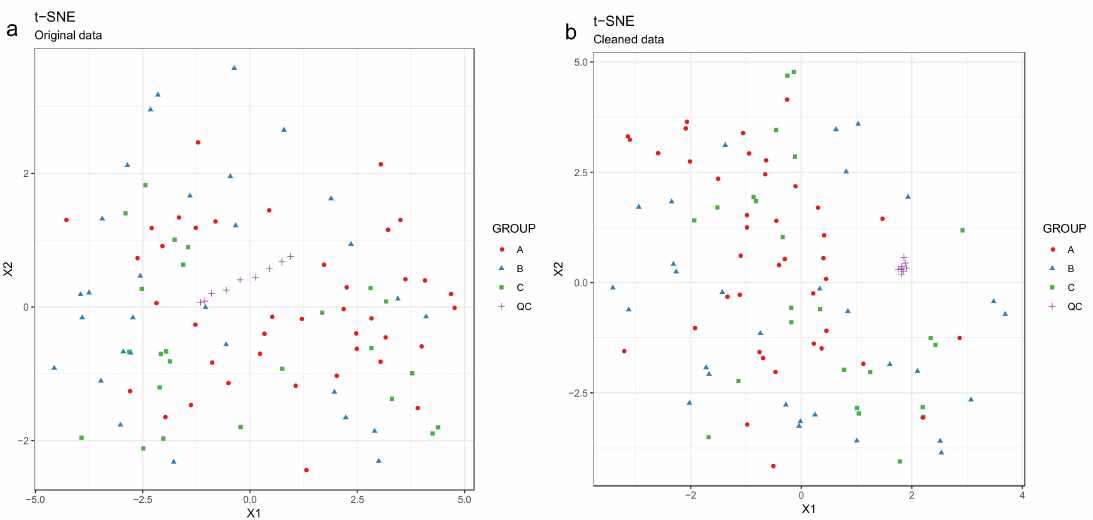
Figure 8. Investigating drift correction patterns using the t-SNE method. The quality control (QC) samples are shifting systematically before drift correction (the line trend of the purple crosses symbol) ( a ), whereas after the drift correction ( b ), the line trend of the QCs is gone and the QCs are now group nicely.